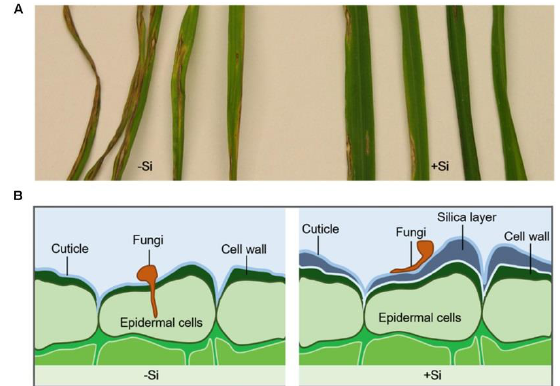
Figure 3. Leaf blast symptoms in rice after inoculated with Magnaporthe grisea for 10 days. Rice plants were continuously treated with (+Si) or without silicon ( − Si) ( A ). Silica layer was formed in the cell wall of Si-treated plants and enhanced plant resistance to fungi infection by physical barriers ( B ). Reprint with permission from [57].